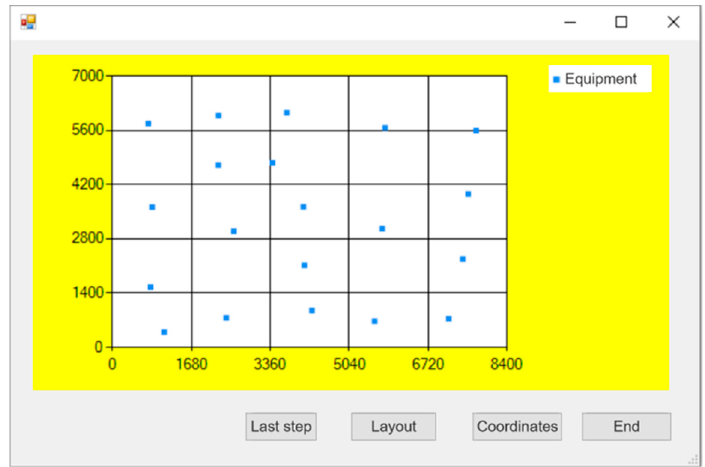
Figure 5. Optimized layout.